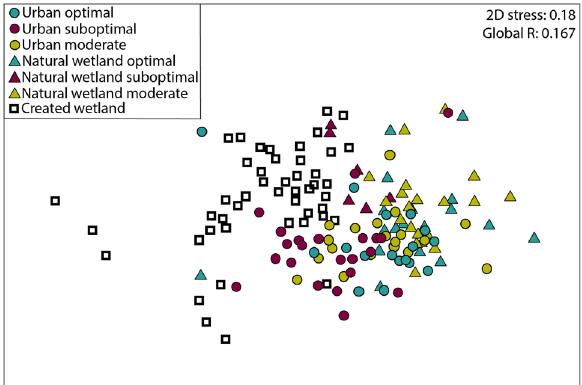
Figure 4. NMDS ordination of prey biomass depicting prey composition in created wetlands and stork boluses across hydrologic conditions and landscape type, South Florida, 2015–2017. Each bolus sample point is representative of prey composition within boluses collected in the same colony on the same date. Each created wetland sample point is representative of the prey composition found within created wetland sites each year. The proximity of points indicates the level of Bray–Curtis similarity in 2-dimensional space. Stress values indicate the degree of distortion relative to the actual multidimensional similarity between points. A stress value less than 0.20 indicates a useful 2-dimensional representation of the